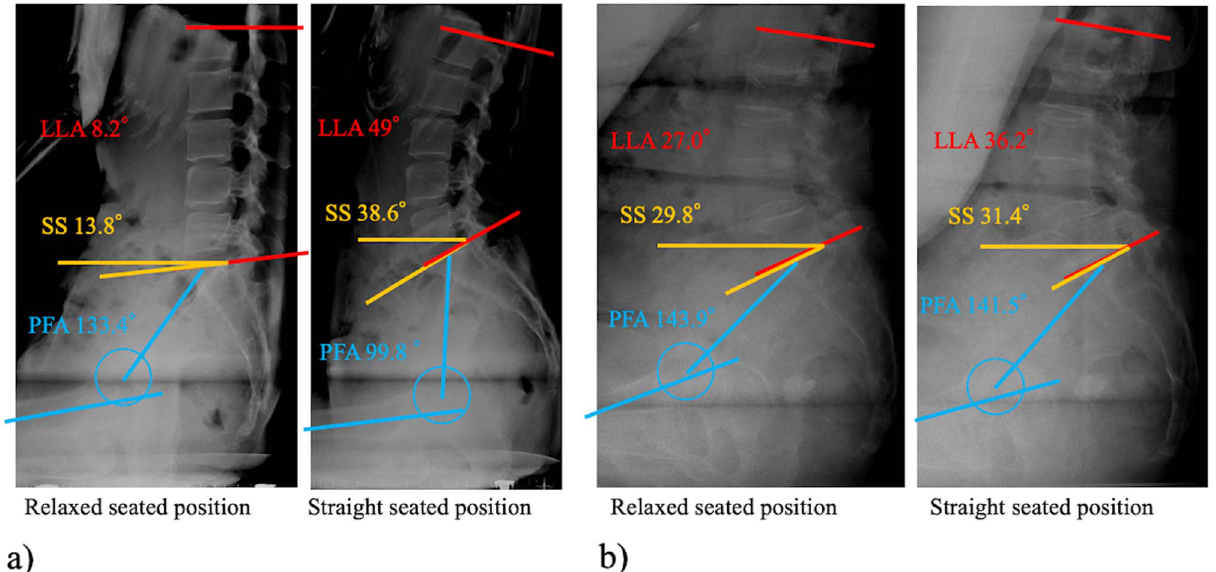
Figure 4. Typical radiographs showing quite the opposite change in spinopelvic sagittal alignments. (a) A 46-year-old female with a large change in sacral slope. Features: posterior rotation of the pelvis and lumbar kyphosis in the relaxed seated position. (b) A 78-year-old female patient with a small change in sacral slope. Features: anterior rotation of the pelvis and lumbar lordosis in the relaxed seated position.